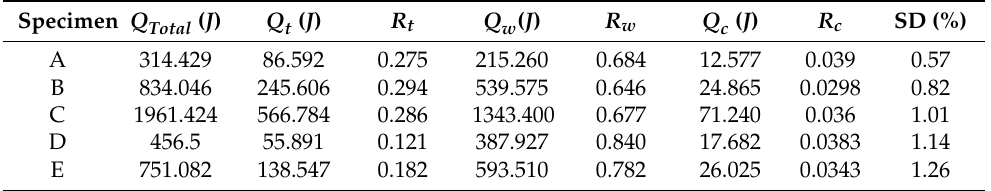
Table 7. Energy partition and heat distribution ratios of edge grinding of the different GFRP lamina- tion